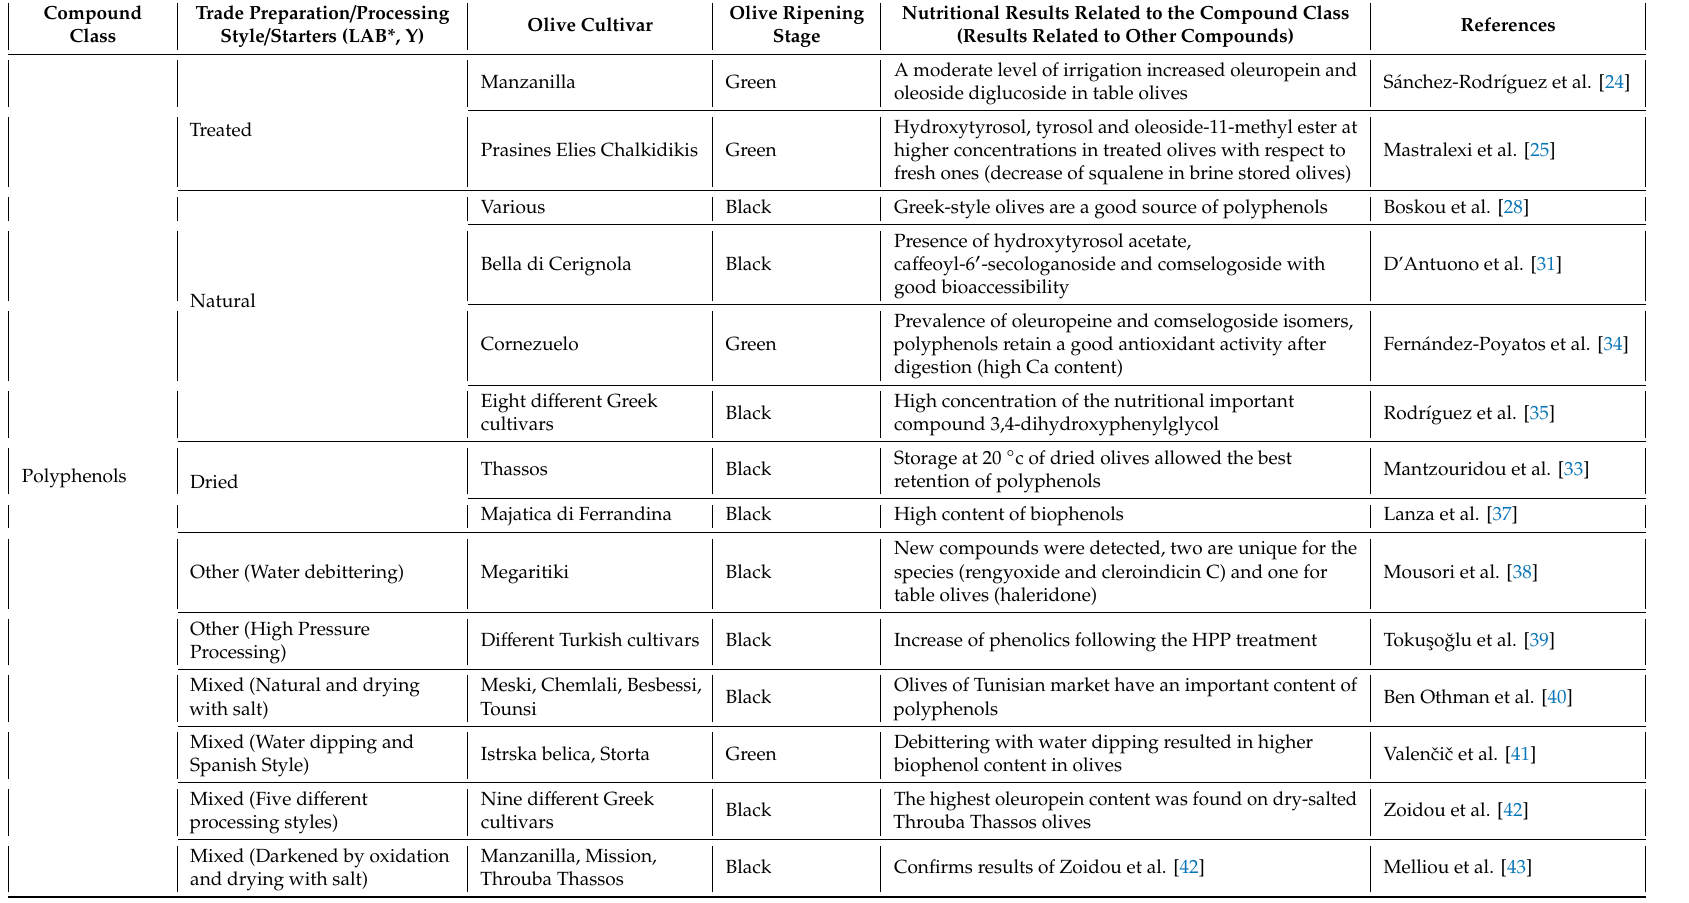
Table 1. E ff ect of trade preparation and processing style on nutritional quality of table